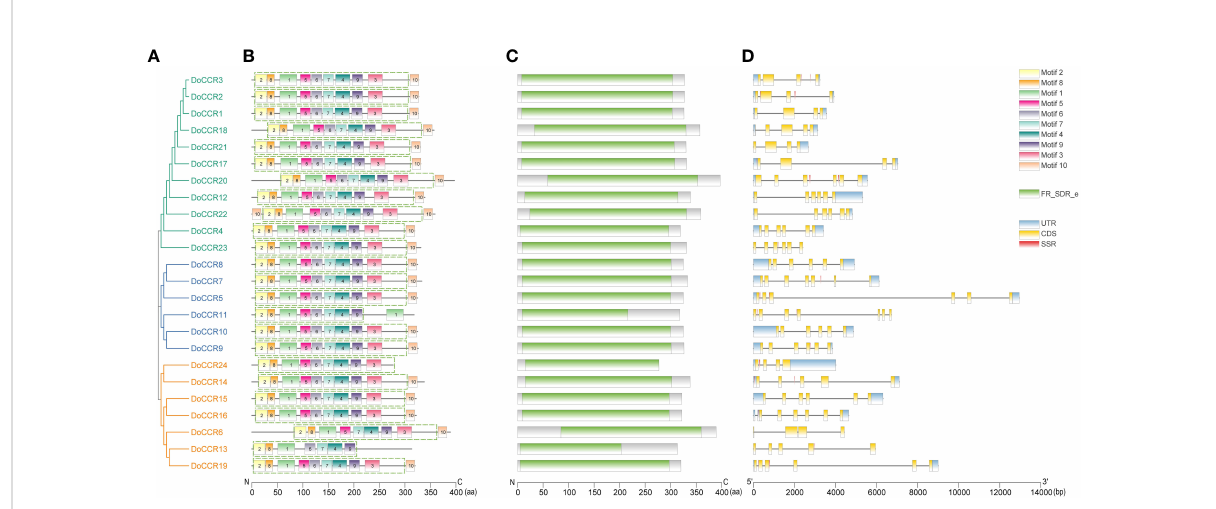
FIGURE 2 Phylogenetic relationship, conserved motifs, conserved domains and gene structures of the DoCCR family. (A) The phylogenetic tree of all DoCCR proteins was constructed using neighbor-joining (NJ) method with 1,000 bootstrap. Different branch colors represent different groupings. (B) Conserved motifs in DoCCR proteins. The motifs, numbers 1-10, were displayed in different colored boxes. The green dashed box indicates the FR_SDR_e domain corresponding to the one in (D) . (C) The conserved domain in the DoCCR proteins. Green boxes indicate FR_SDR_e domain, which identi fi ed by CDD database. The units on the bottom scale are the number of amino acids. (D) The exon-intron structure of DoCCR genes. Exons and introns were indicated by boxes and single lines. The thin blue boxes represent UTRs, yellow boxes represent CDSs and grey lines represent introns. Additionally, the red boxes represent SSR (excluding mononucleotide